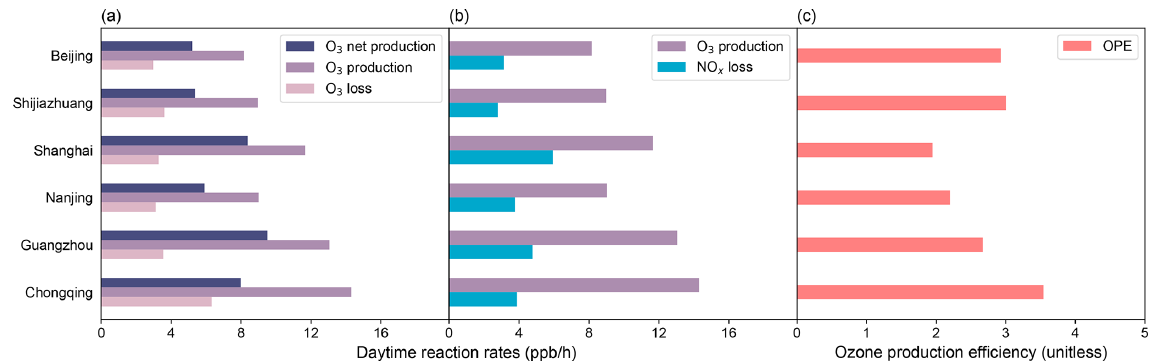
Figure 6. Simulated surface daytime (a) net O 3 production rates, gross O 3 production rates and gross O 3 loss rates (ppbh − 1 ); (b) gross O 3 production rates and NO x loss rates (ppbh − 1 ); and (c) OPE (unitless) for the six industrial regions in JJA, 2016,